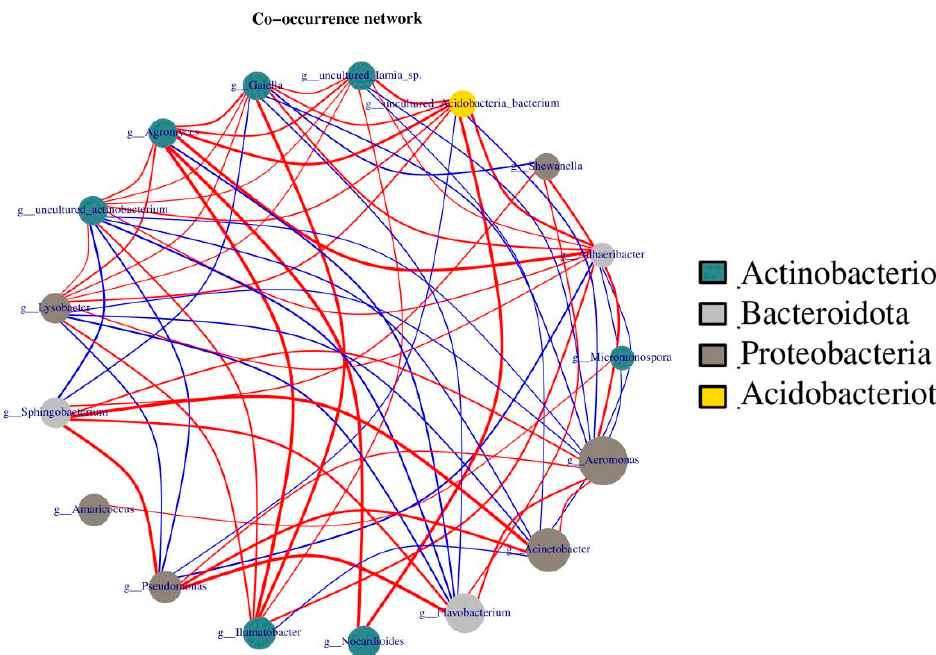
Figure 10. Analysis of microbial networks in cow dung and vermicompost products. The size of the dots represents abundance, the thickness of the lines represents correlation, the colors of the dots represent the phylum to which they belong, the red lines represent positive correlation, and blue lines represent negative correlation.